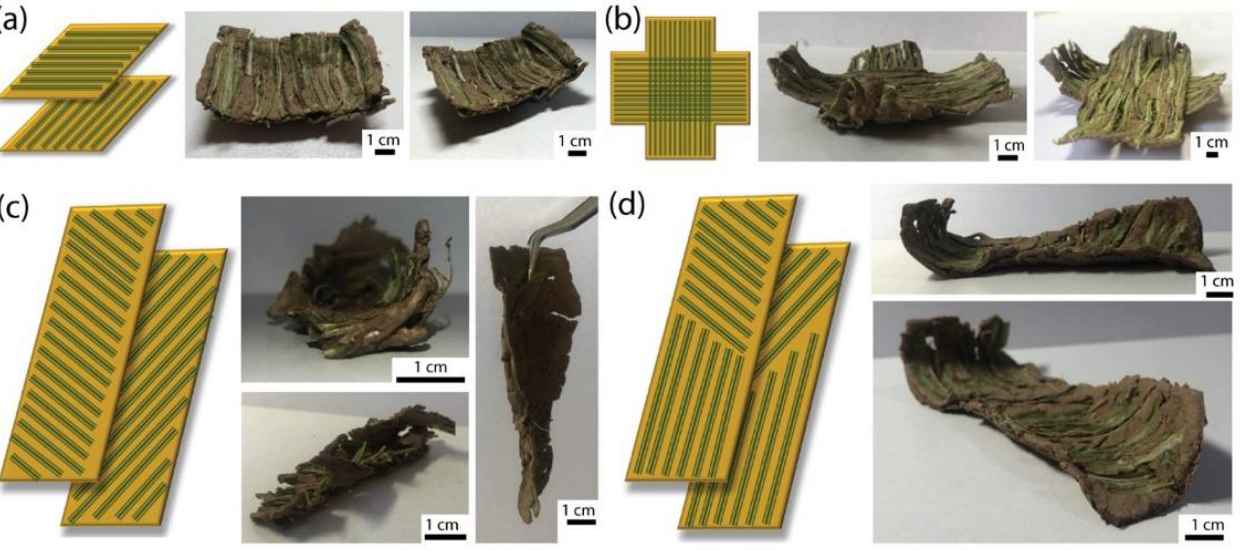
Figure 8. Clay-based samples with bioinspired self-shaping. ( a ) A bilayer sample with fiber aligned in perpendicular direction, bending in both directions; ( b ) A cross-shaped bilayer sample with fiber aligned in perpendicular direction, bending in the directions where fibers were aligned; ( c ) A bilayer with fibers aligned at 45° in two different directions, resulting in twisting; ( d ) A bilayer with fibers in the upper part were aligned at 45° cross and that in the lower part were aligned parallel.